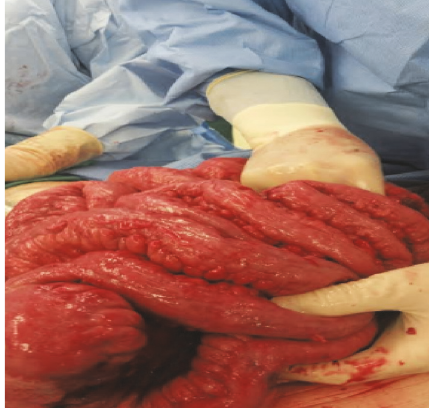
Figure 3: Variegated and pebble like peritoneum and bowel.